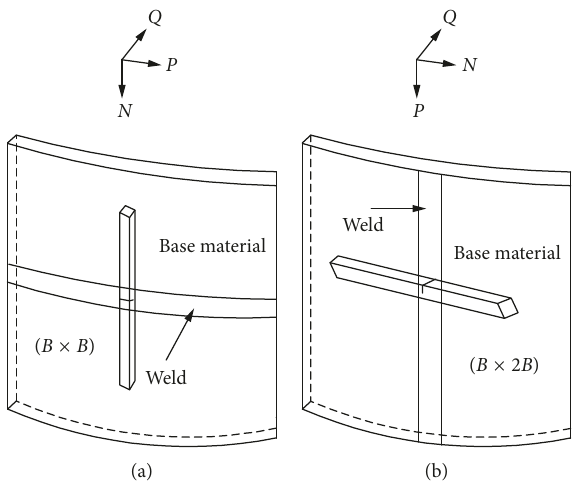
Figure 3: Schematic diagram of CTOD sample interception. (a) HAZ; (b)